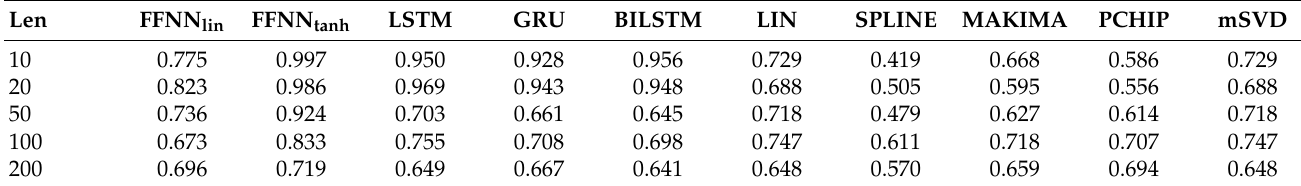
Table A7. Correlation between RMSE and standard deviation of input